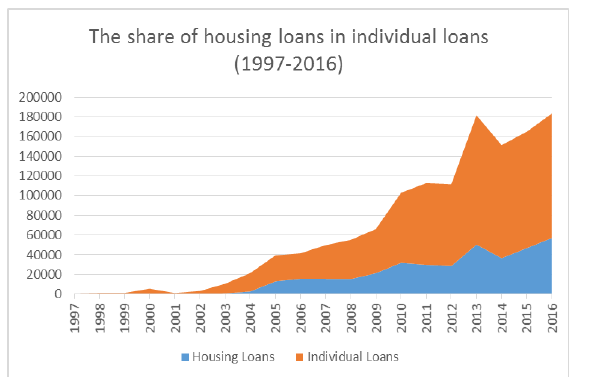
Figure 11. Trend of Housing Loans’ Interest Rate as of End of Year (2002-2017*) Source: TCMB,